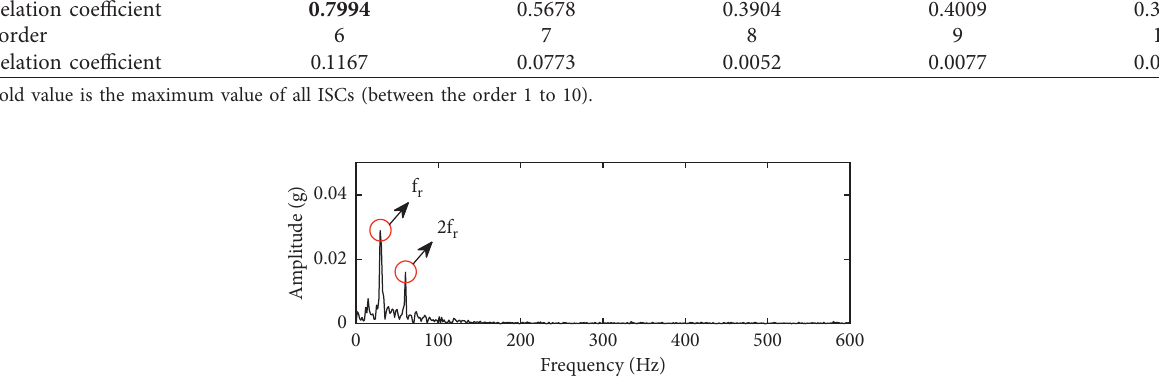
Figure 10: Vector LCD spectra of x-channel under normal